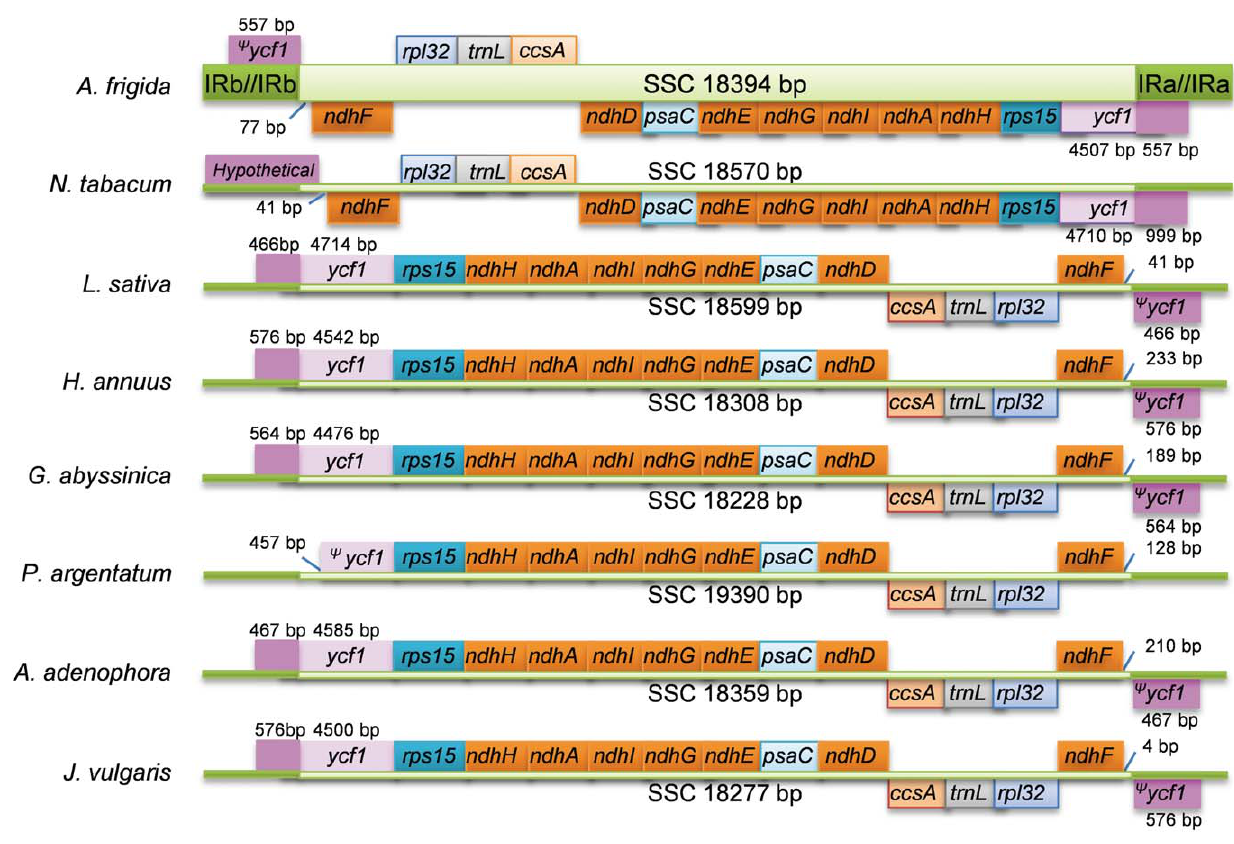
Figure 3. Comparison of the SSC region among different Asteraceae species. Gene sequences in the SSR region were annotated and indicated along the green lines. Genes above the green lines indicate their transcriptions in forward direction and genes below the green lines represent their transcriptions in reverse direction.